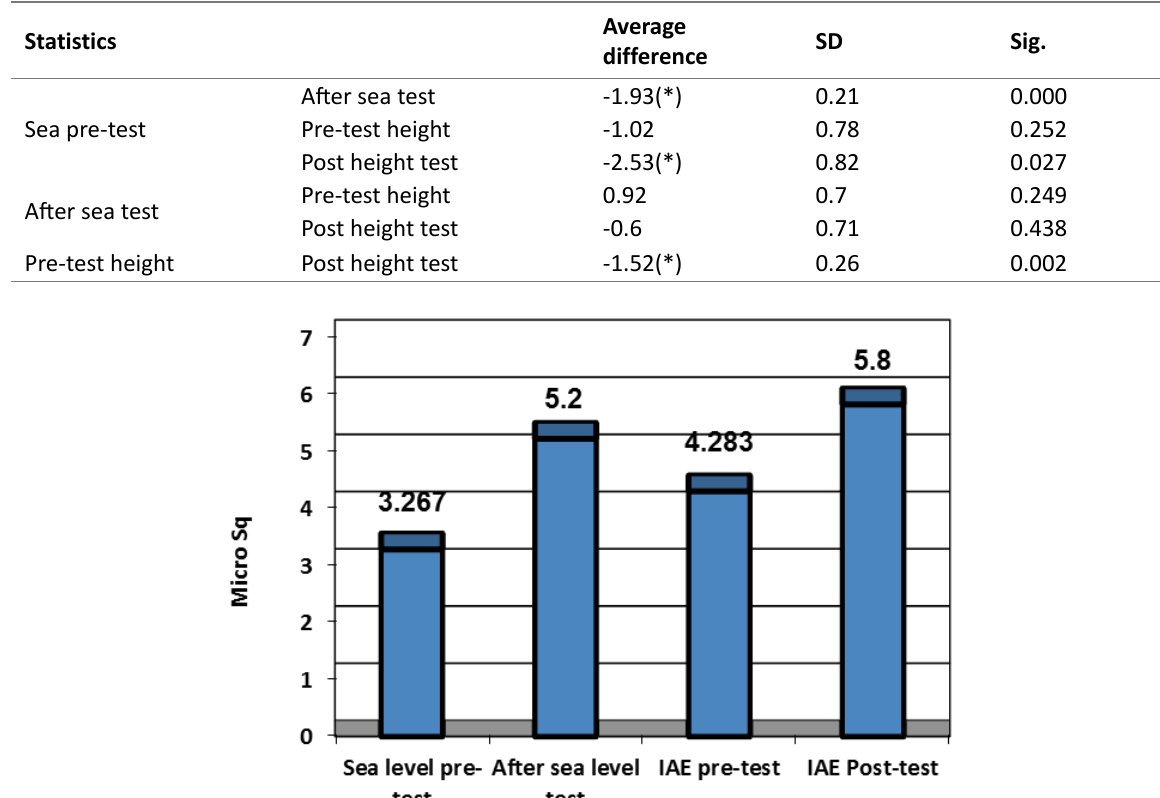
Figure 3. Average changes in neutrophil